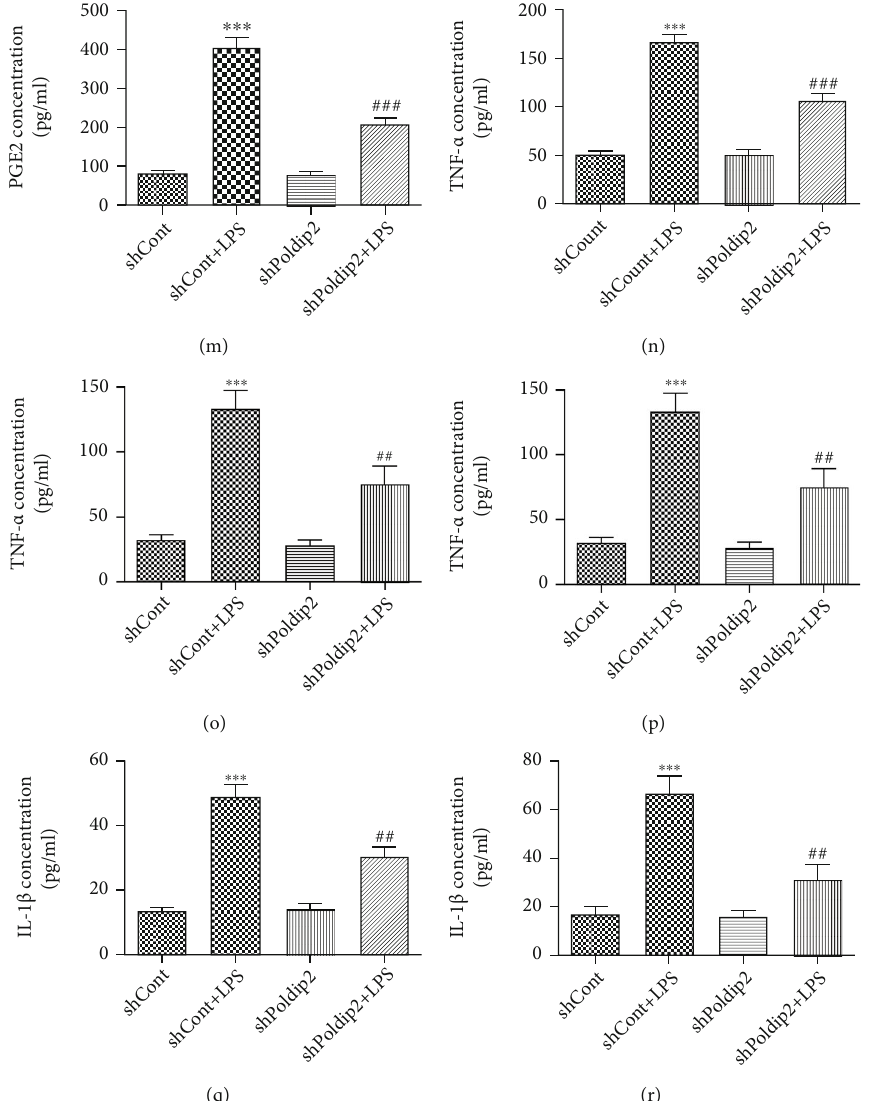
Figure 5: Downregulation of Poldip2 decreased LPS-induced oxidative stress and in fl ammation. (a, b) Con fl uent A549 and Beas-2B cells were transfected with the lentivirus downregulation vector for 72h, and the e ffi ciency of Poldip2 downregulation was veri fi ed by Western blotting and quantitatively analyzed. Following transfection, they were treated with LPS (10 μ g/mL for A549 cells and 1 μ g/mL for Beas-2B cells) for 12h. (c, d) The protein levels of Nox4, HO-1, and COX-2 were detected by Western blotting and quantitatively analyzed. (e – g, i) The expression of Nox4 in the transfected cells was detected by immuno fl uorescence analysis and laser confocal microscope. The cells were stained with Nox4 (green) and counter stained with DAPI (blue) (magni fi cation of 400x). (h, j) The NADPH enzymatic activity in cells was detected by a spectrophotometer. (k, l) The production of intracellular ROS was detected by fl ow cytometry. (m – r) The expression levels of PGE2, TNF- α , and IL-1 β in the supernatant were detected by ELISA. Bars are mean ± SD of 3 independent experiments. ∗∗∗ P < 0 : 001 vs. shCont, ∗∗ P < 0 : 01 vs. shCont, ∗ P < 0 : 05 vs. shCont, ### P < 0 : 001 vs. shCont + LPS , ## P < 0 : 01 vs. shCont + LPS , and # P < 0 : 05 vs. shCont + LPS